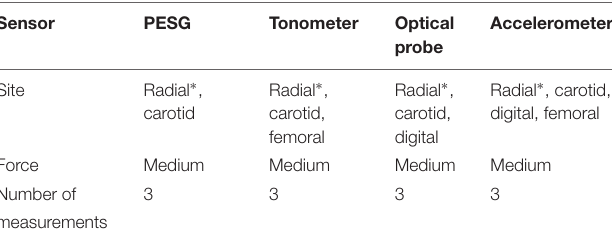
TABLE 3 | The sequence of pulse wave acquisitions ( ∗ marks the measurement position for the reproducibility and stability